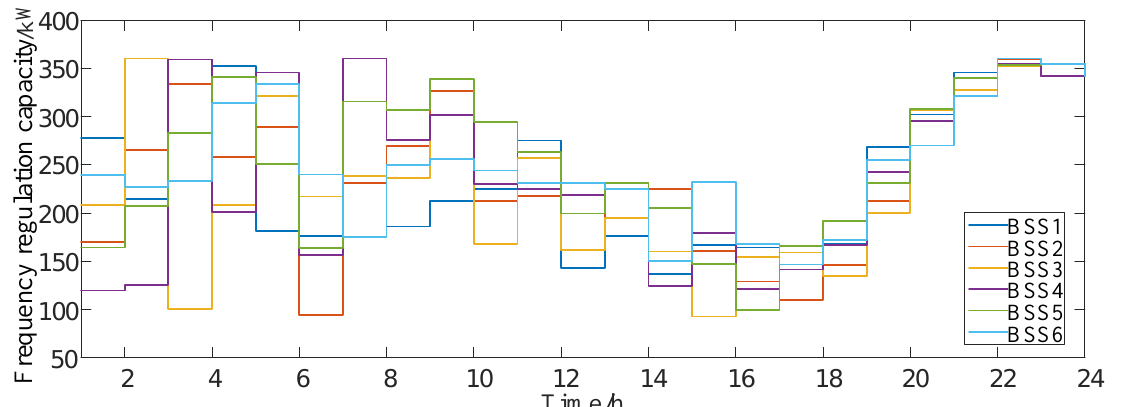
Figure 3. Available FR capacity of each BSS.